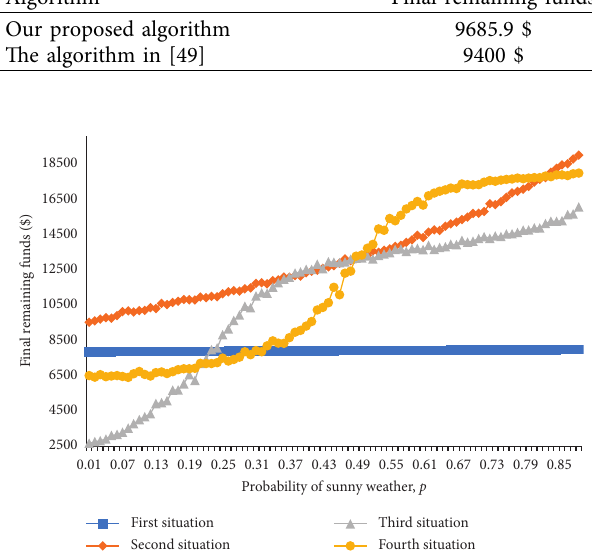
Figure 20: Comparison of four situations in Level 4.